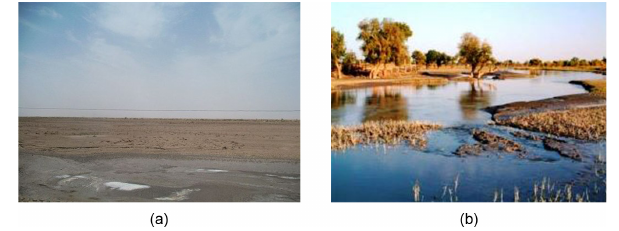
Fig. 8. Landscape around the Taitema Lake (a) around the 1970s when it was dry (adapted from http://pp.fengniao.com/photo_ 3809084.html); (b) and since 2000 after it had been refilled arti- ficially through water transfers (adapted from